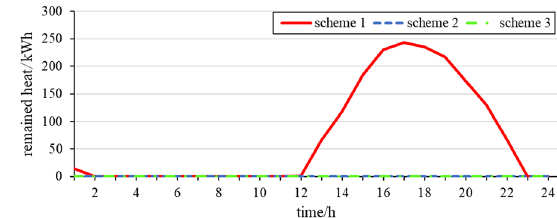
Fig. 11 Water temperature and heated water volume of collector in winter